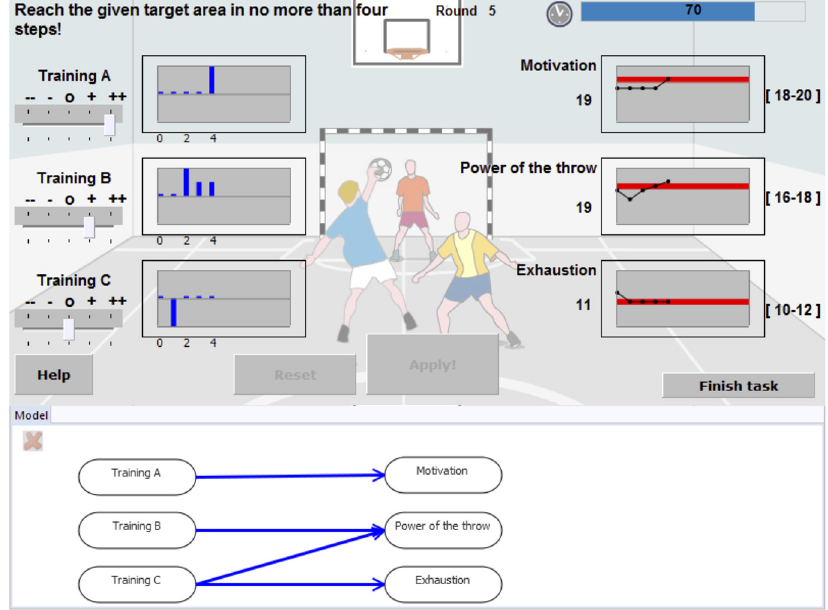
Figure 2. Screenshot of the MicroDYN item “Handball”: The participant has to find out how the input variables to the left are connected to the output variables on the right. Below the working area is an area for depicting the assumed causal structure.